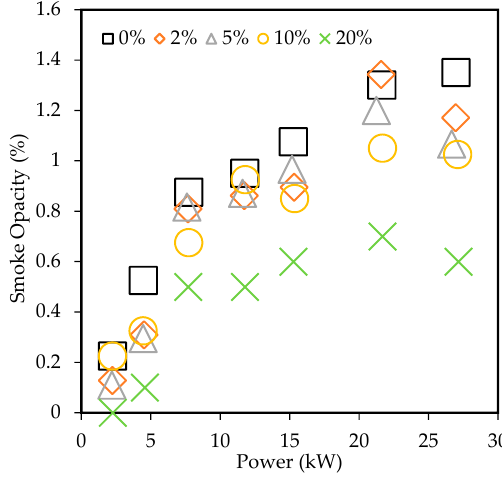
Figure 12. Variations in smoke opacity of tested fuel types.